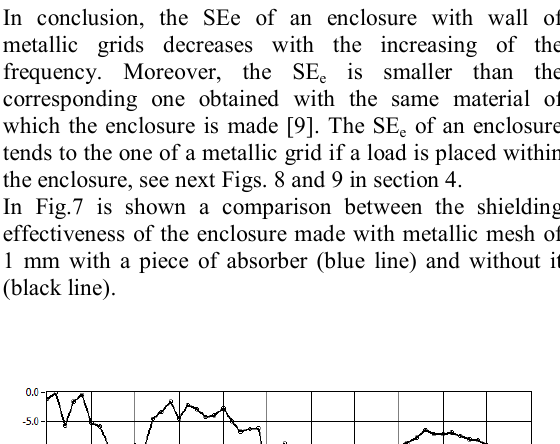
Figure 2: A sketch of the IUN RC with a particular of the enclosure made with mesh size of 1 mm.